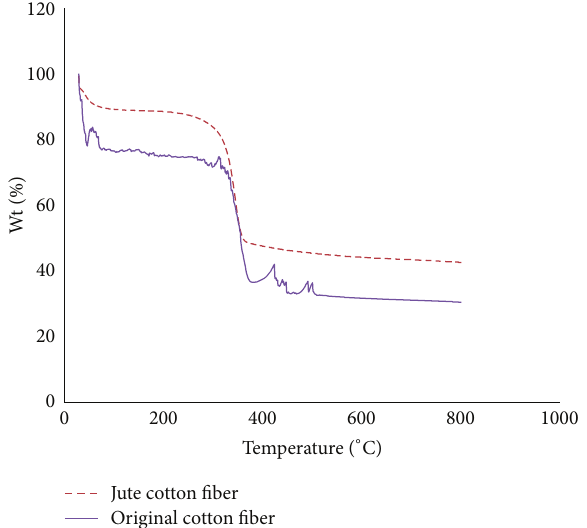
Figure3: TGAcurvesofjutecottonfibersandoriginalcottonfibers.